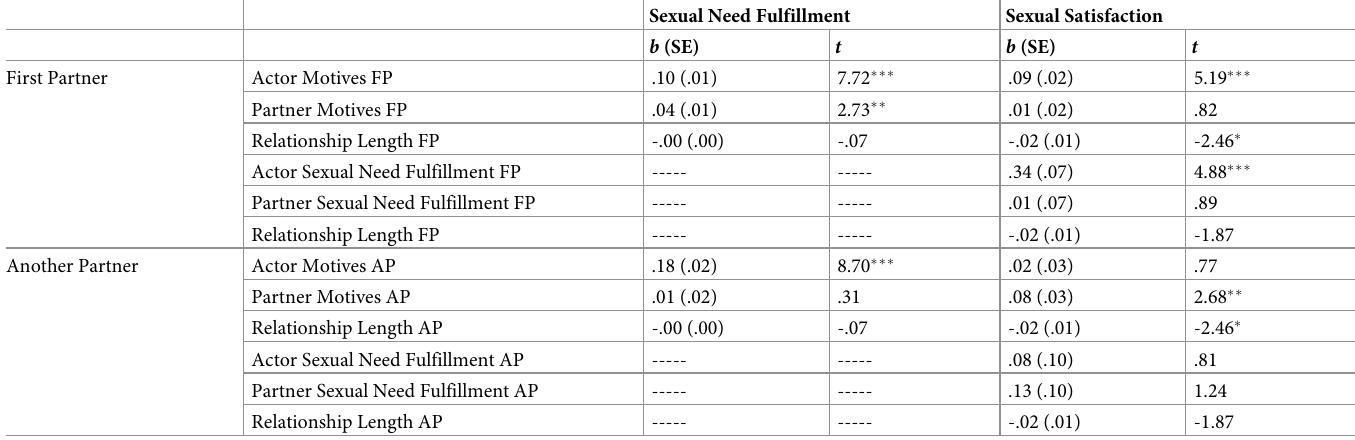
Table 6. Daily associations between actor and partner sexual motives, sexual need fulfillment, and sexual satisfaction (with participants’ first partner) by partner